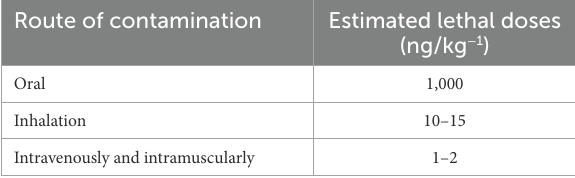
TABLE 4 Estimated lethal doses for BoNT/A1 in